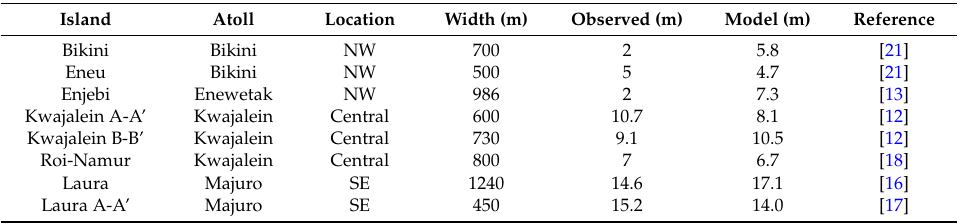
Table 1. List of available observed freshwater lens thickness for six different islands in the Republic of Marshall Islands. The results of using the algebraic model are presented in the “Model” column.